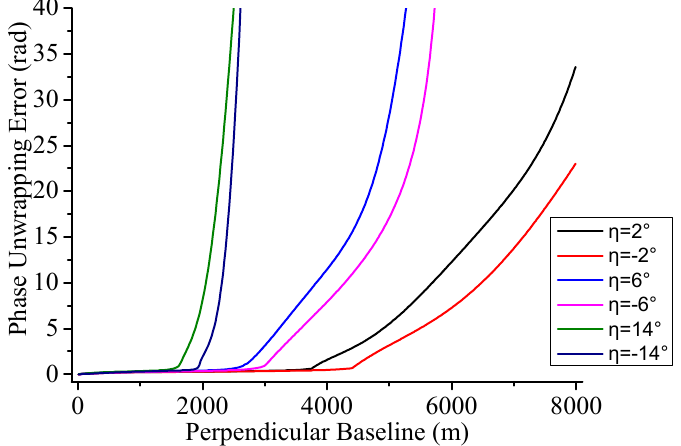
Figure 6. Comparison of the fitted PUE curves under different positive and negative slopes, taking η = ± 2 ◦ , η = ± 6 ◦ , and η = ± 14 ◦ as